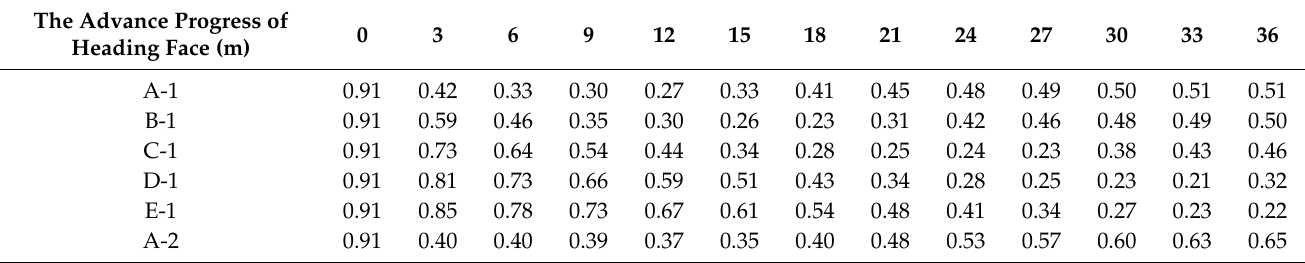
Table 5. Variation diagram of pore water pressure at arch bottom (Unit: MPa).